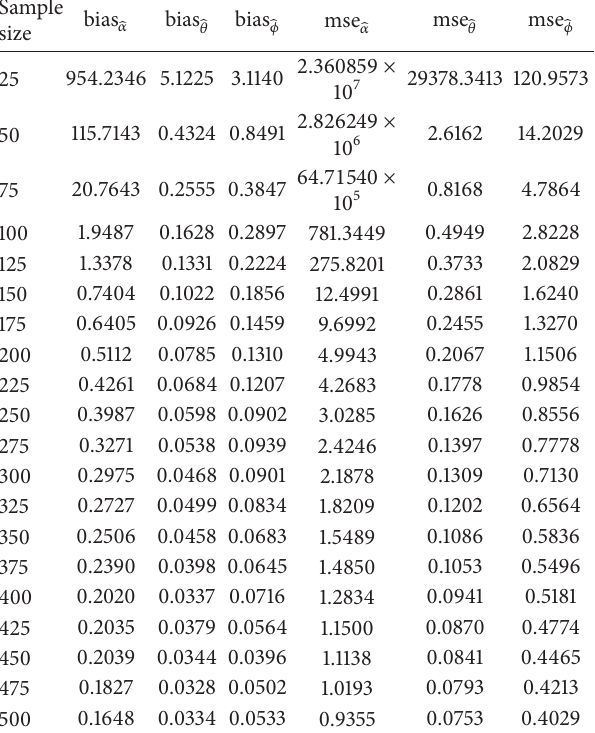
Table 6: Monte-Carlo simulation results of the estimators bias and mse of the EG type-2 distribution with parameters: 𝛼 = 3.00 , 𝜃 = 4.00 , and 𝜙 = 5.00 for different sample